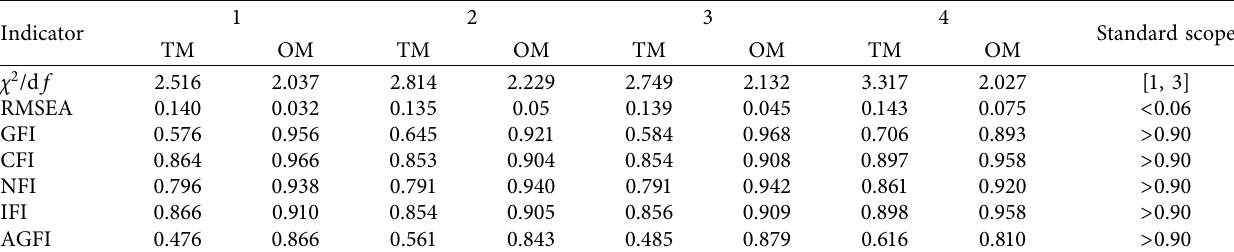
Table 5: SEM fitting index